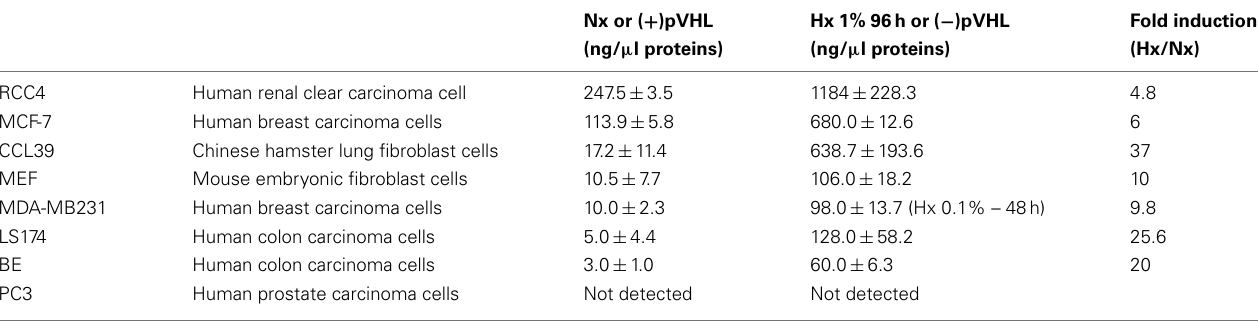
Table 1 | Basal level and glycogen accumulation (ng/ μ g proteins) after 96h of hypoxia in normal (CCL39 and MEF) and cancer (BE, MCF-7, MDA-MB231, LS174, PC3, RCC4) cells.